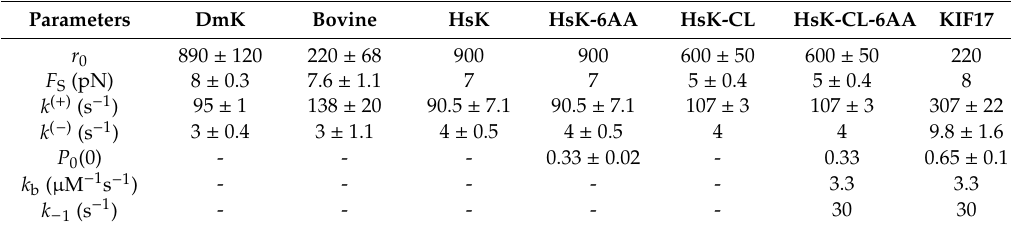
Table 1. Values of parameters for di ff erent species of kinesin